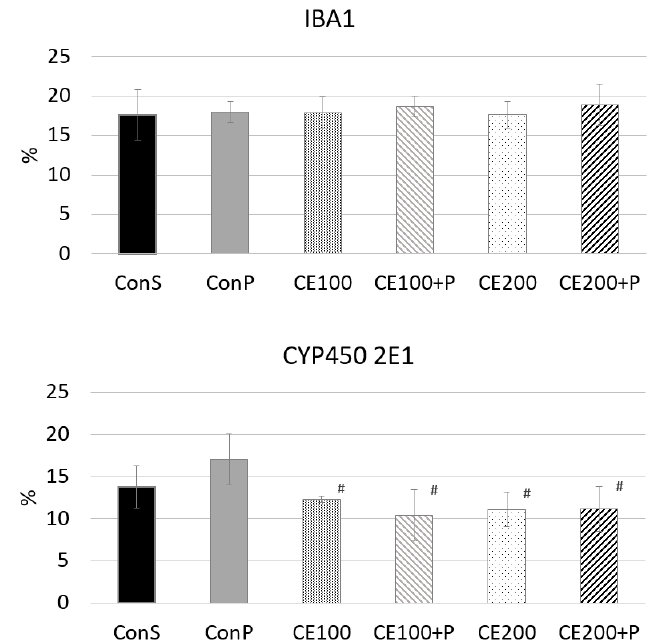
Figure 5. Morphometric analysis of liver tissue of healthy animals and animals with paracetamol- induced liver injury (# p < 0.05 significantly different from ConP).